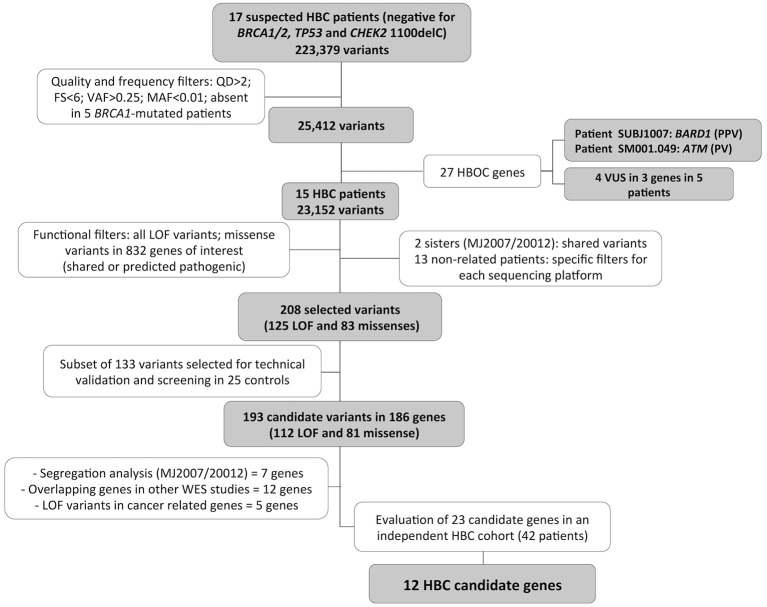
Variants selection workflow. WES data from 17 breast cancer patients were analyzed using quality, frequency, and functional based filters, resulting in 186 breast cancer predisposing candidate genes. A final 23 candidate genes were entirely investigated for LOF or possibly pathogenic variants in 42 additional BC patients suspected of HBC and negative for mutations in the major predisposing genes, resulting in 12 final HBC candidate genes. FS, FisherStrand; QD, QualByDepth; PPV, probably pathogenic variant; PV, pathogenic variant; HBOC, Hereditary Breast and Ovarian Cancer; LOF, loss of function; SA, segregation analysis; WES, whole exome sequencing.